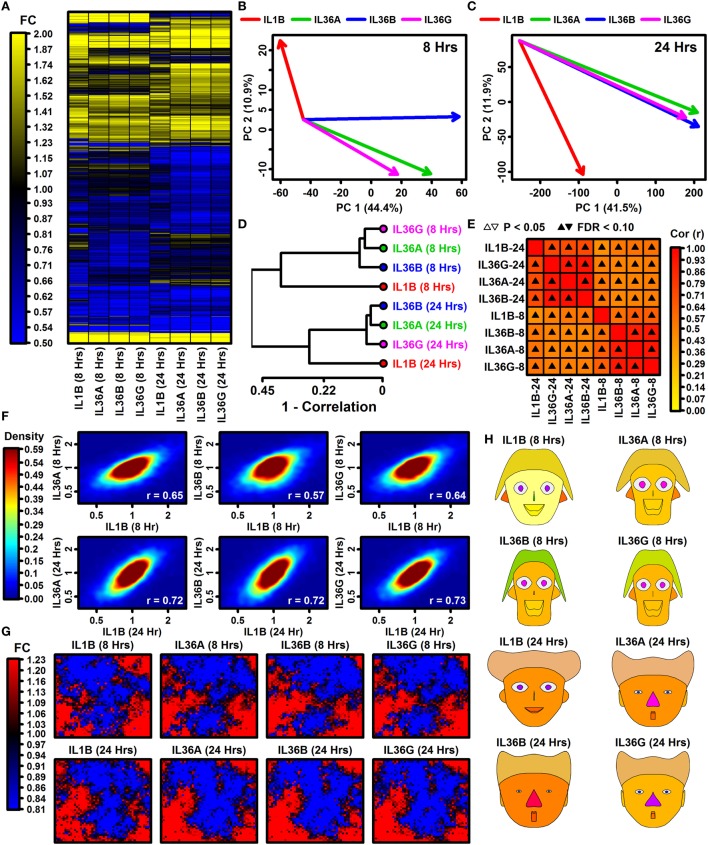
Global transcription responses to IL-1B and IL-36 (RNA-seq). (A) FC heatmap. The heatmap shows FC estimates [cytokine/control (CTL)] from 7,059 keratinocyte (KC)-expressed genes altered with respect to at least 1 cytokine (P < 0.05; FC > 1.50 or FC < 0.67). Hierarchical gene clustering was performed using average linkage and Euclidean distance. RNA-seq experiments were replicated with n = 2 or 3 samples per treatment. (B,C) Principal component (PC) response vectors. Arrows begin at the CTL sample bivariate PC mean and end at the bivariate PC mean for the indicated cytokine. (D) Cluster analysis. Cytokine responses were clustered based upon the expression changes for 13,752 KC-expressed genes (distance = 1 − Spearman rank correlation). (E) Correlations among cytokine responses (13,752 KC-expression genes; Spearman rank correlation). (F) Comparison of IL-36 cytokine responses to IL-1B. Colors reflect gene density within the scatterplot (see scale; bottom right: Spearman rank correlation). (G) Self-organizing maps (SOMs). The SOM layout was determined based upon expression patterns of all KC-expressed genes. Colors reflect the average FC estimate (cytokine/CTL) for genes assigned to a given SOM region. (H) Chernoff faces. Face features are scaled or color-coded to reflect cytokine responses for 15 selected genes (see Materials and Methods). The genes were chosen by algorithm as representatives of clusters with different IL-1B and IL-36 response profiles.